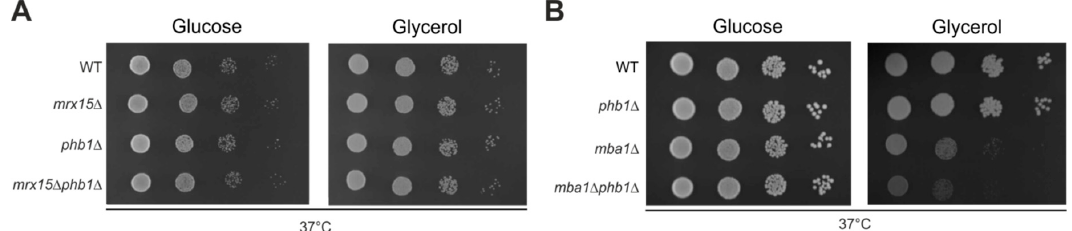
Figure 4. MBA1 functionally interacts with PHB1 . ( A ) and ( B ) Serial dilution growth test on fermentable (glucose) and non-fermentable (glycerol) carbon sources of indicated strains. Cells were grown to logarithmic phase, spotted in 10-fold dilutions, and incubated at 37 °C.